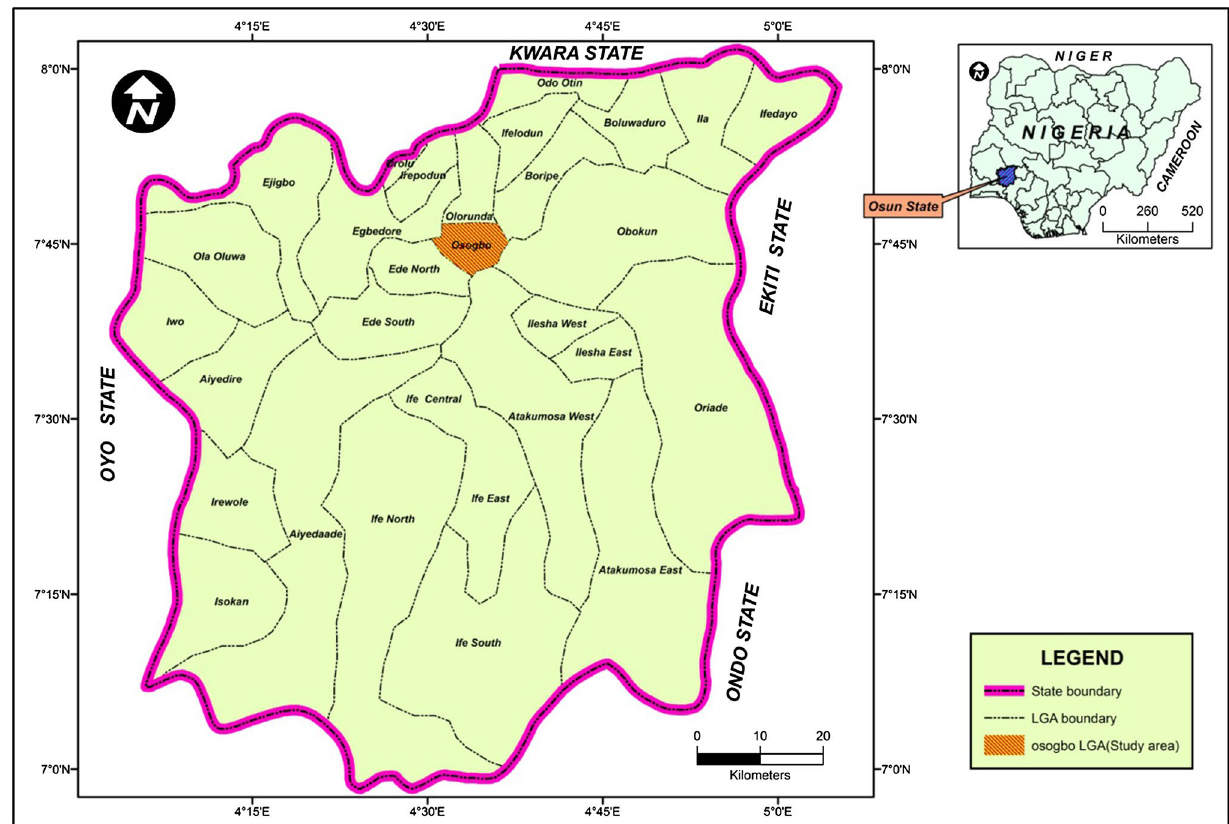
Fig. 1 Map of Osun state showing Osogbo the study